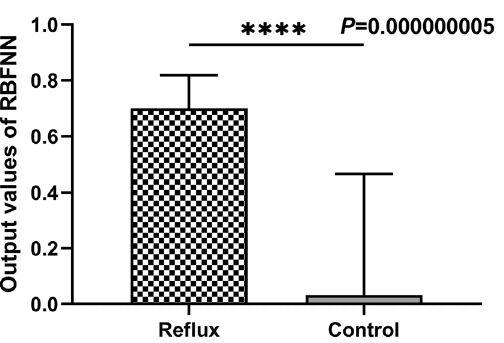
Figure 6. Correspondence of RBFNN outputs for the classification of pre-intervention patients with venous reflux and healthy controls. (****, P < 0.0001, unpaired two-tailed Student’s t